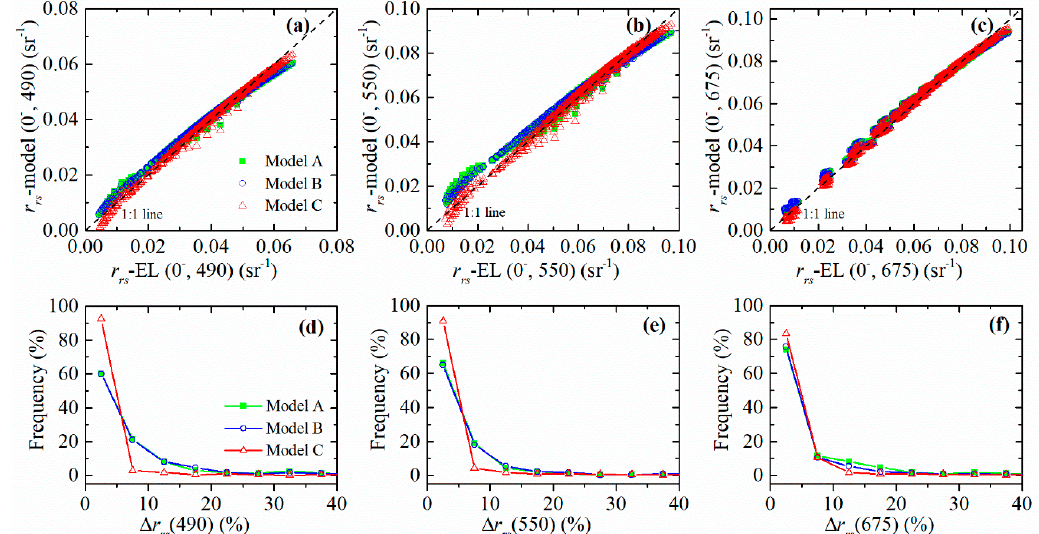
Figure 11. Performances of Model A, Model B, and Model C: ( a – c ) comparisons between modeled r rs (0 − ) and Ecolight-simulated r rs (0 − ) at 490, 550, and 675 nm, respectively; ( d – f ) frequency of ∆ r rs (0 − ) of different models at 490, 550, and 675 nm, respectively.